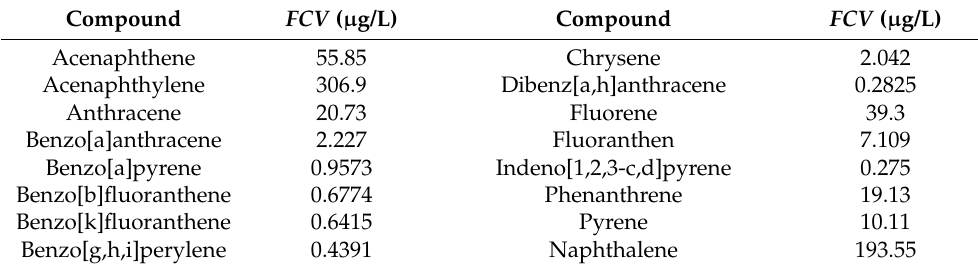
Table 2. The final chronic values for the 16